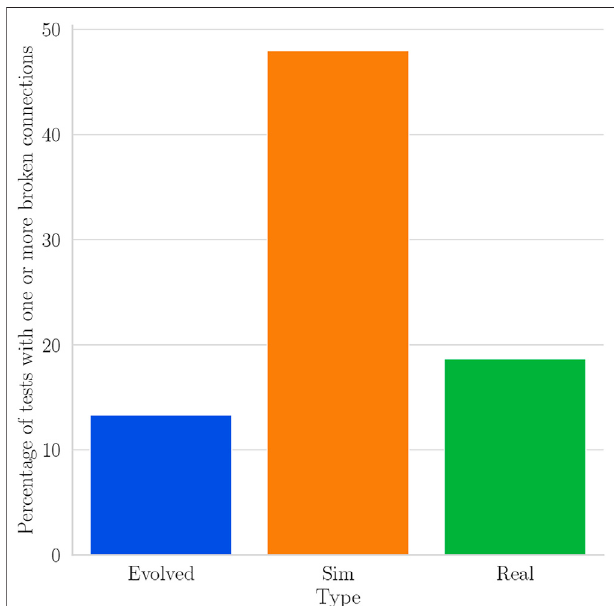
FIGURE 9 | Percentage of tests with one or more broken connections forrealrobots(Real),simulatedrobotswithnoiseinthecontroller(Sim)andthe original test performed in simulation in the evolutionary run (Evolved).